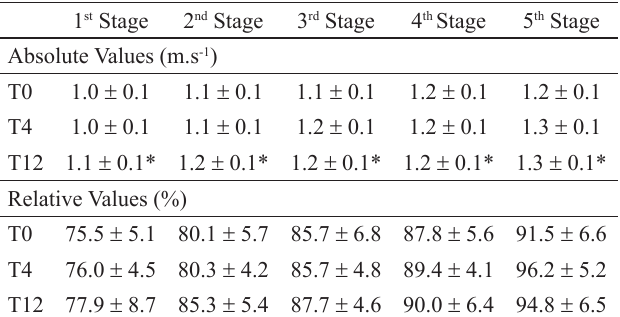
3. Mean ± standard deviation of the absolute values and relative values—expressed as percentage of the maximal effort of 200m—of the intensities of each stage of the GET during T0, T4, and T12.